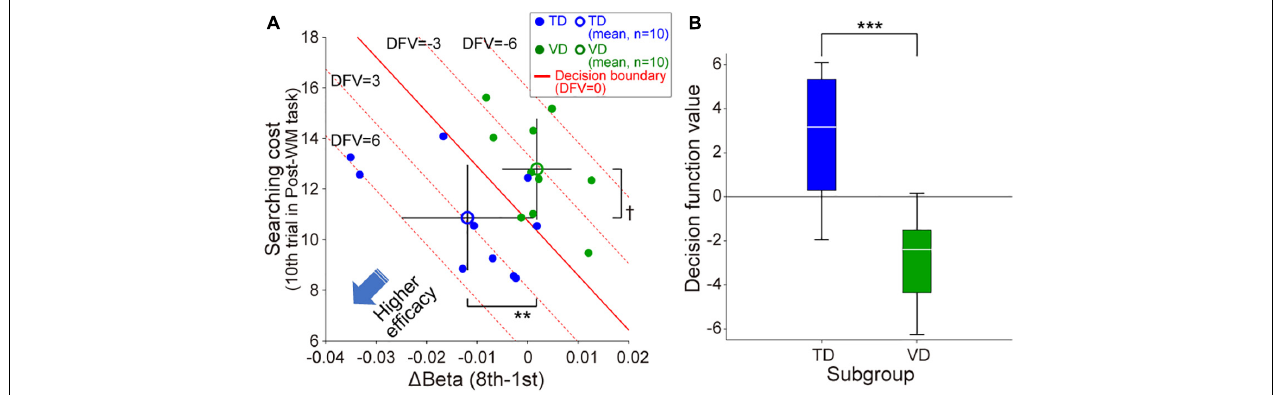
FIGURE 4 | Individual modality dominance dependency of neurofeedback training efficacy in the Real group. (A) Scatter plot of the individual neurofeedback training efficacy based on the beta value change in ch.11 and WM task performance in the Post-WM task. TD-individuals are relatively distributed in the lower left of the scatter plot compared with the VD individuals. The red solid line indicates the decision boundary estimated by linear discriminant analysis [i.e., the decision function value (DFV) is zero on this decision boundary]. The red dotted lines represent other DFVs (6, 3, –3, and –6, respectively). Error bars of the mean values denote the standard deviation. (B) The decision function values for the TD-individuals were significantly higher than those for the VD individuals. † p < 0.1, ** p < 0.01, *** p <